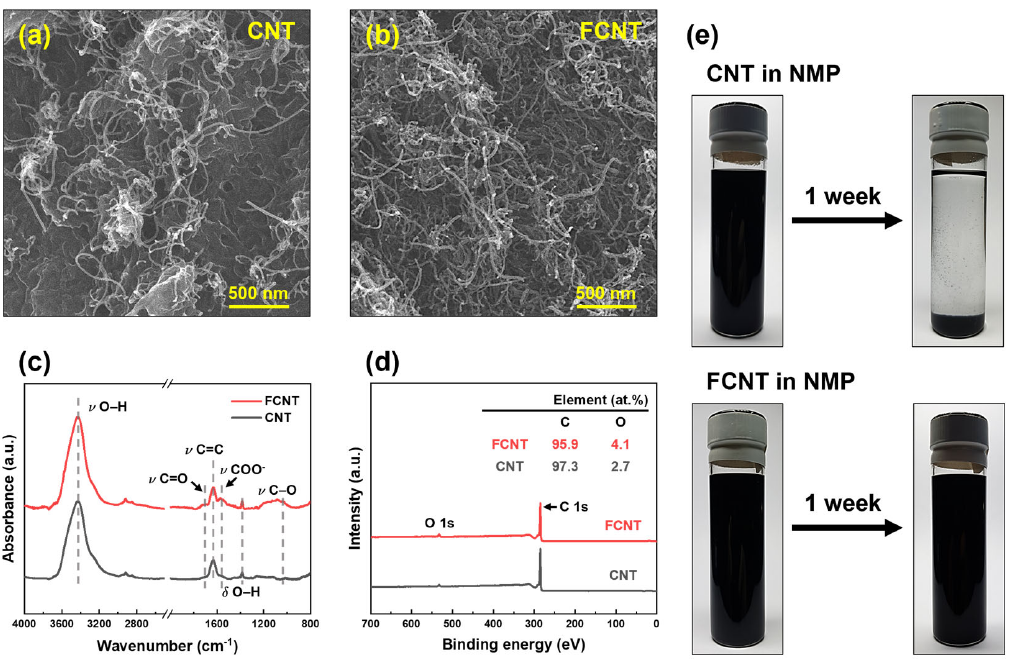
Figure 2. Characteristics of CNT and FCNT. ( a , b ) Microstructure. ( c ) ATR-FTIR spectra. ( d ) XPS spectra. ( e ) Dispersibility and stability.